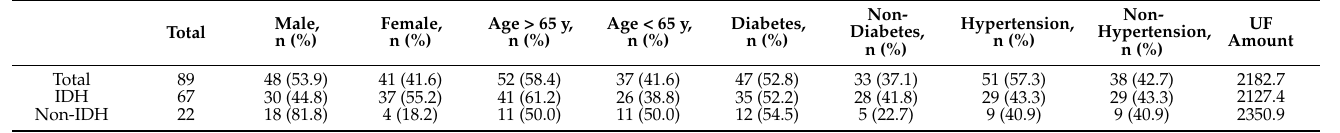
Table 2. Baseline characteristics of the patients in IDH and non-IDH